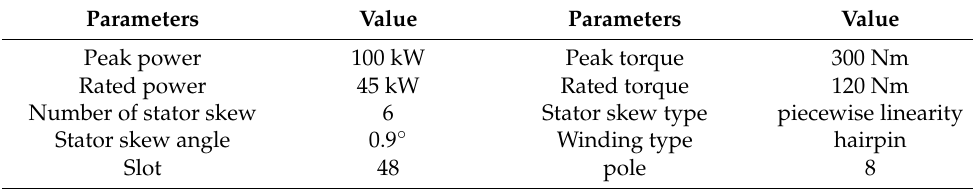
Table 1. Parameters of permanent synchronous electrical